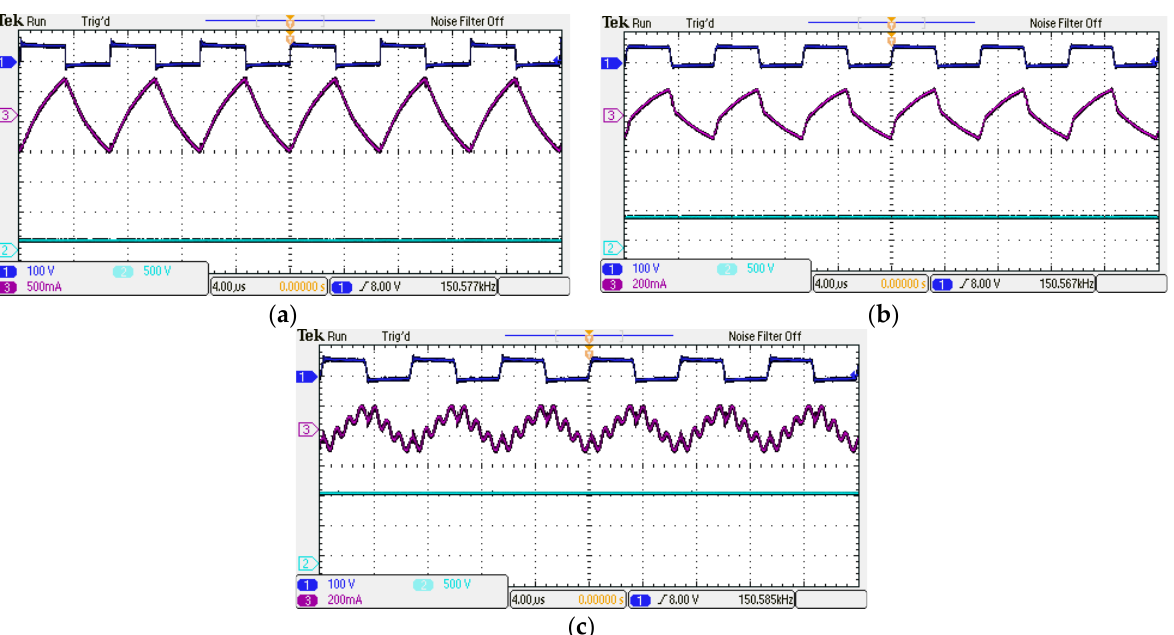
Figure 18. LLC resonant converter improvement for primary ‐ side switches at the above resonant frequency f SW = 150 kHz: (1) V AB as blue; (2) I R as purple; (3) V OUT as turquoise; ( a ) full load; ( b ) light load Q = 0.2; ( c ) open